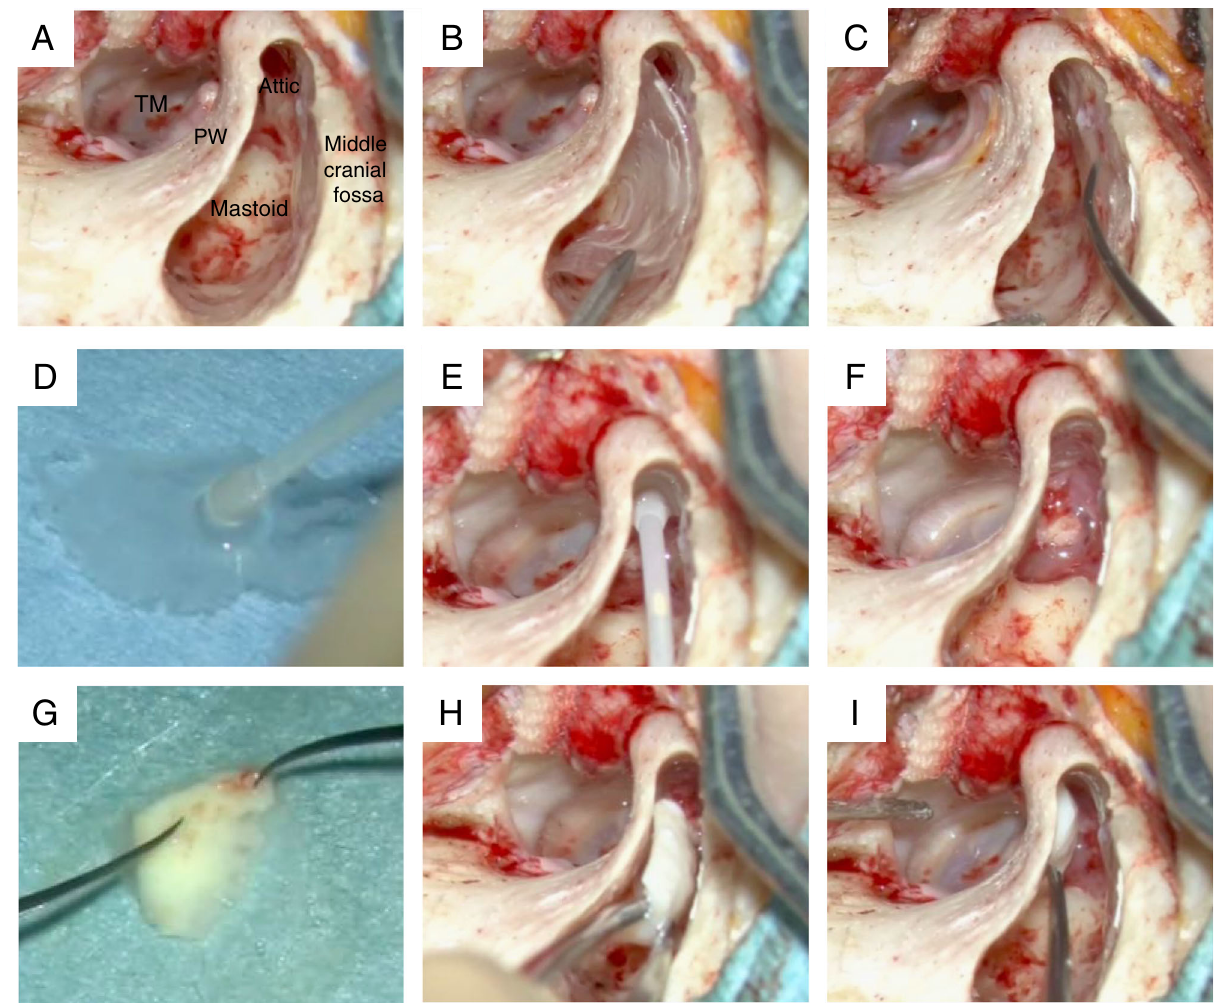
Fig. 4 Outline of the various procedures for cell sheet transplantation into the mastoid cavity and attic under a microscope following canal wall up tympanoplasty. a Micrograph of the mastoid cavity and attic after canal wall up tympanoplasty in cholesteatoma patients who had undergone mastoidectomy. b The cell sheet was delivered into the mastoid cavity on a supportive silicon plate and the surface containing the cell sheet was pressed onto the exposed bone surface in the middle cranial fossa. c The silicone plate was removed and the cell sheet was spread onto the exposed bone surface in the middle cranial fossa. d Using a device equipped with a 1-mL syringe probe, the central portion of a cell sheet was aspirated, and the sheet was held with the tip of the device. e The cell sheet was fully aspirated into the syringe probe tip, the device holding the sheet was placed just outside of and pointed toward the narrow attic, and the cell sheet was extruded in manner resembling an in fl ated parachute. f The extruded cell sheet was spread out as fully as possible to cover the attic bone surface, completing the cell sheet transplantation. g A cell sheet was placed on a piece of auricular cartilage harvested for use in scutumplasty. The cell sheet is placed on the surface that becomes the mastoid cavity side of the auricular cartilage. h The cartilage combined with the cell sheet was placed into the attic. i The cartilage combined with the cell sheet was carefully pressed to the scutum. To prevent recurrence of cholesteatoma, scutumplasty was performed transplanting a hybrid implant composed of a cell sheet covering a piece of auricular cartilage. TM: tympanic membrane, PW: posterior canal